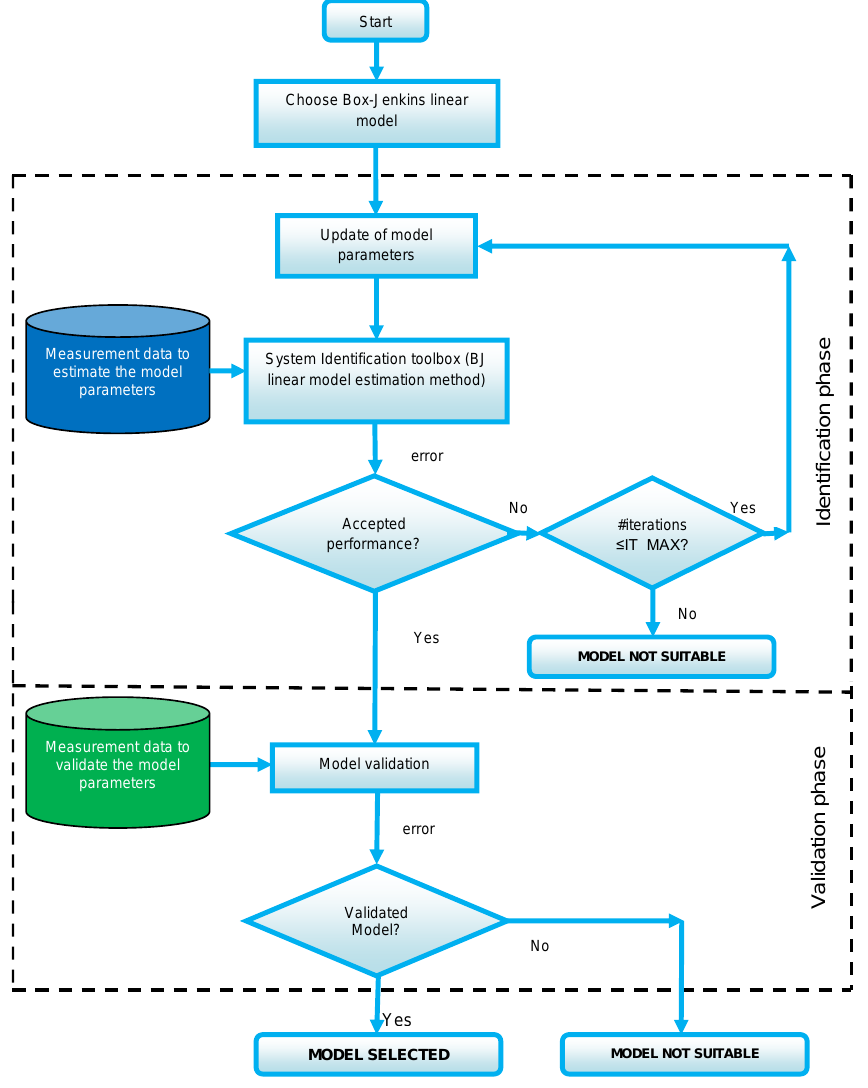
Figure 5. Flowchart of the battery cell identification procedure.